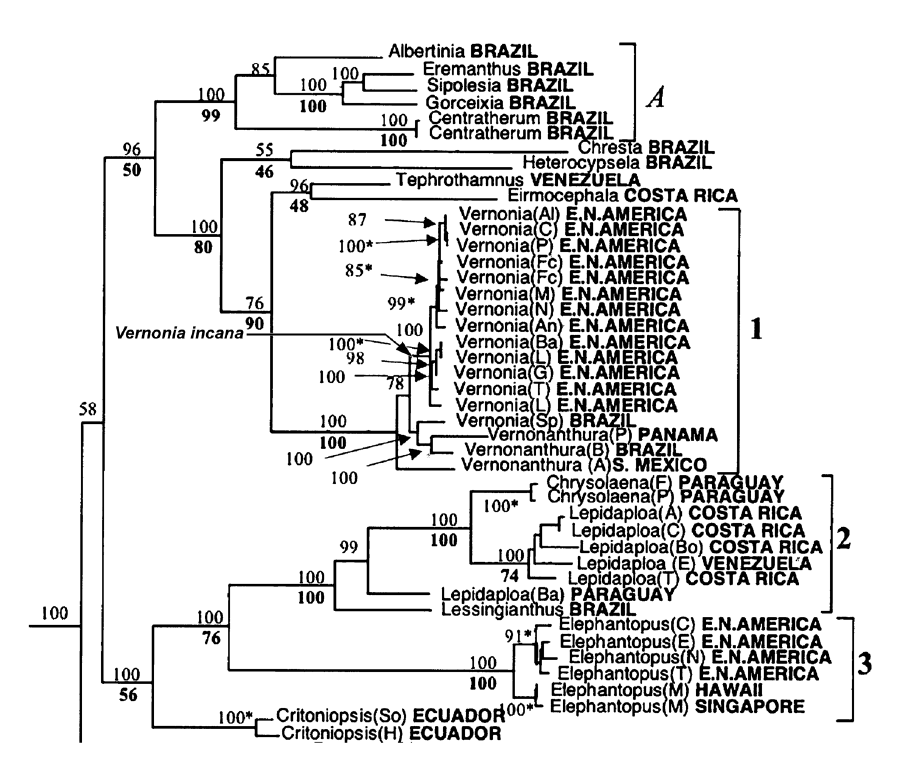
Figure 2. Phylogeny with an indication of where Vernonia incana Less. is placed (arrow). The phylogeny is modified from Keeley et al. 2017 and does not take into account all the taxa that were in the analysis performed by the authors using data from Keeley et al. (in